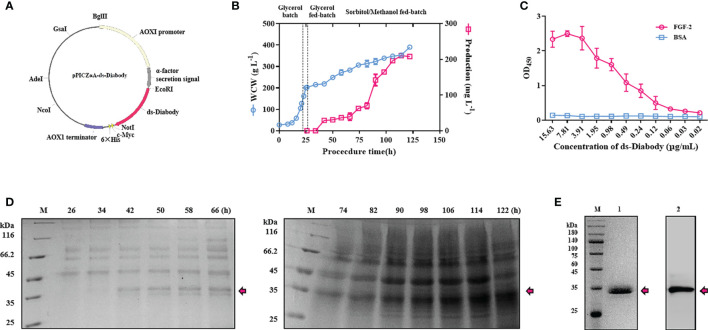
The fermentation, purification and binding activity studies of ds-Diabody against FGF-2 in Pichia pastoris. (A) Schematic illustration of the recombinant expression plasmid of pPICZαA-ds-Diabody. (B) The curve of cell wet weight and the production of ds-Diabody against FGF-2 in Pichia pastoris fermentation for strategy II. (C) The antigen combined activity of ds-Diabody against FGF-2 by ELISA. (D) The SDS-PAGE assays of ds-Diabody against FGF-2 in fermentation for strategy II. (E) The purification of ds-Diabody. Lane M, marker; Lane 1, the SDS-PAGE assay of the purified ds-Diabody in reducing condition; Lane 2: the Western blot assays of the purified ds-Diabody.